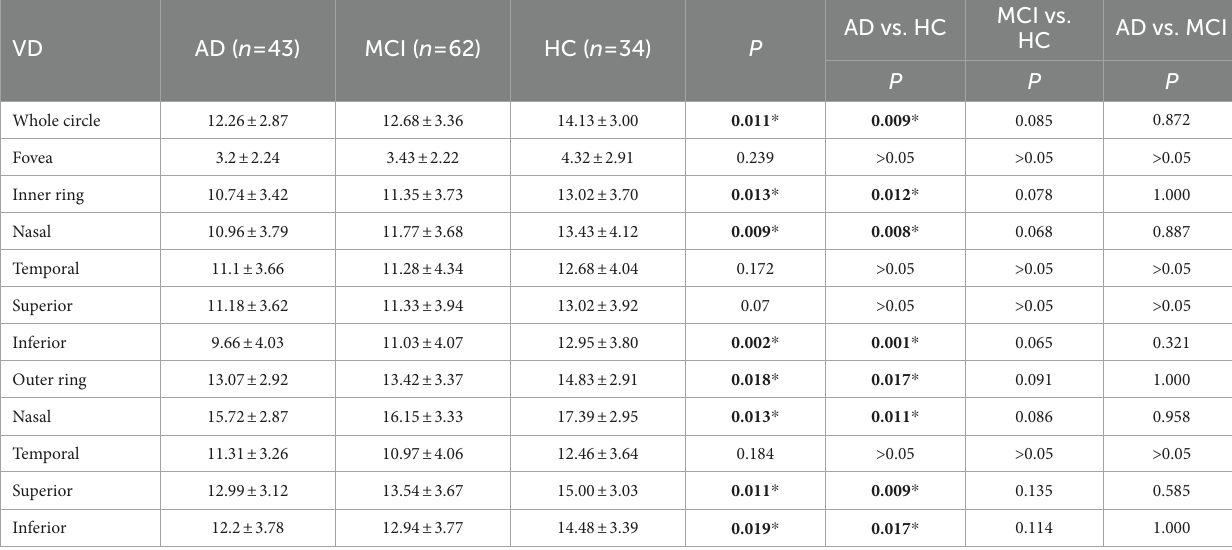
TABLE 3 Comparison of vessel density in macular among the three